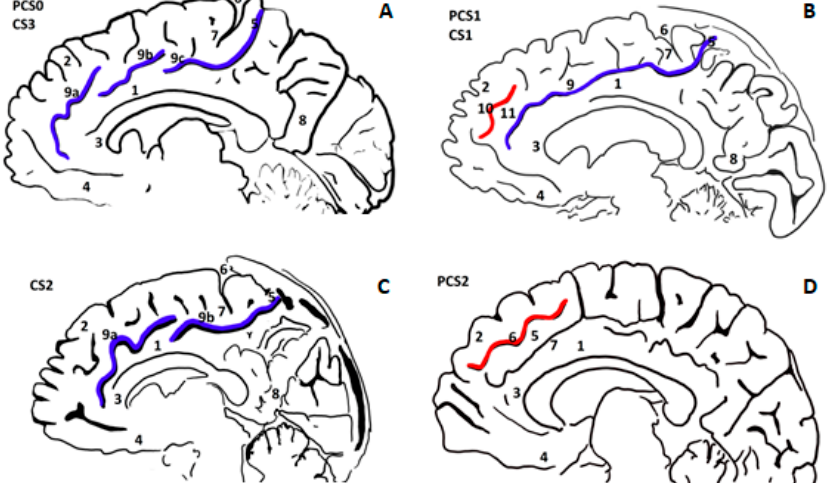
Figure 2. CS and PCS delineations on the medial hemisphere (right) of the brain. Combinations PCS0 and CS3, PCS1 and CS1, PCS2 alone, and CS2 alone do not reflect their co-occurrence in the patients; they were clustered together for better illustration. PCS0 means there is no paracingulate sulcus or its length is shorter than 2 cm. ( A ) PCS0 and CS3: 1—cingulate sulcus, 2—superior frontal